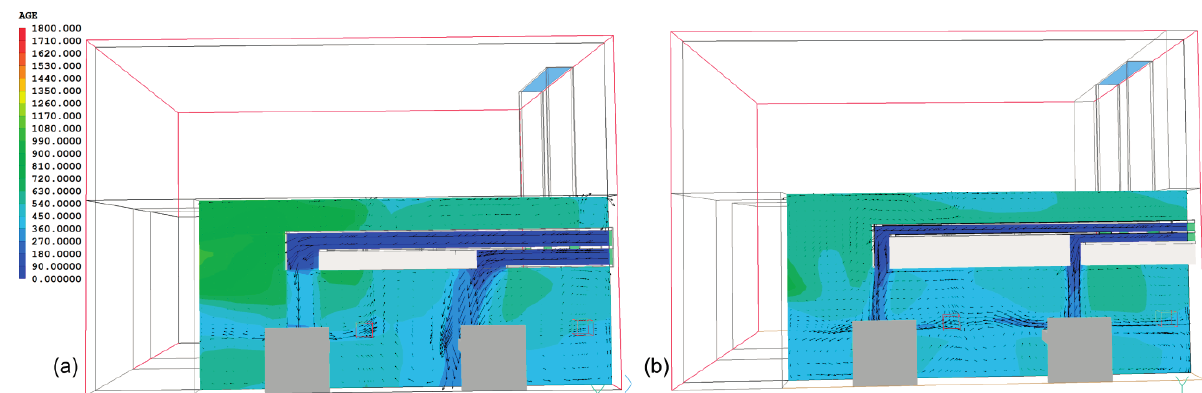
Figure 8. 2D contours and vectors indicating directionality of air in: ( a ) The original Top–Bottom design; ( b ) The narrow vertical air discharge